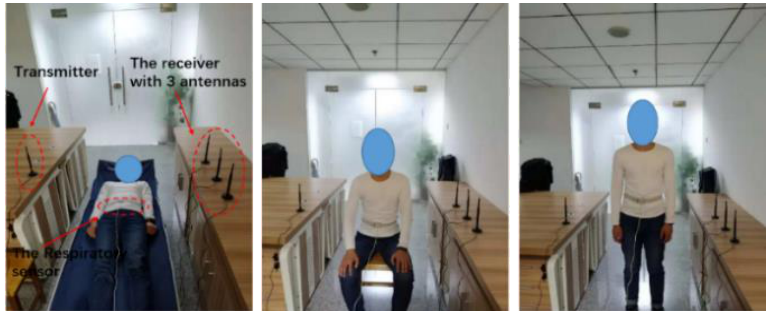
Figure 2. C-band sensing-based human respiratory activity information detection model.